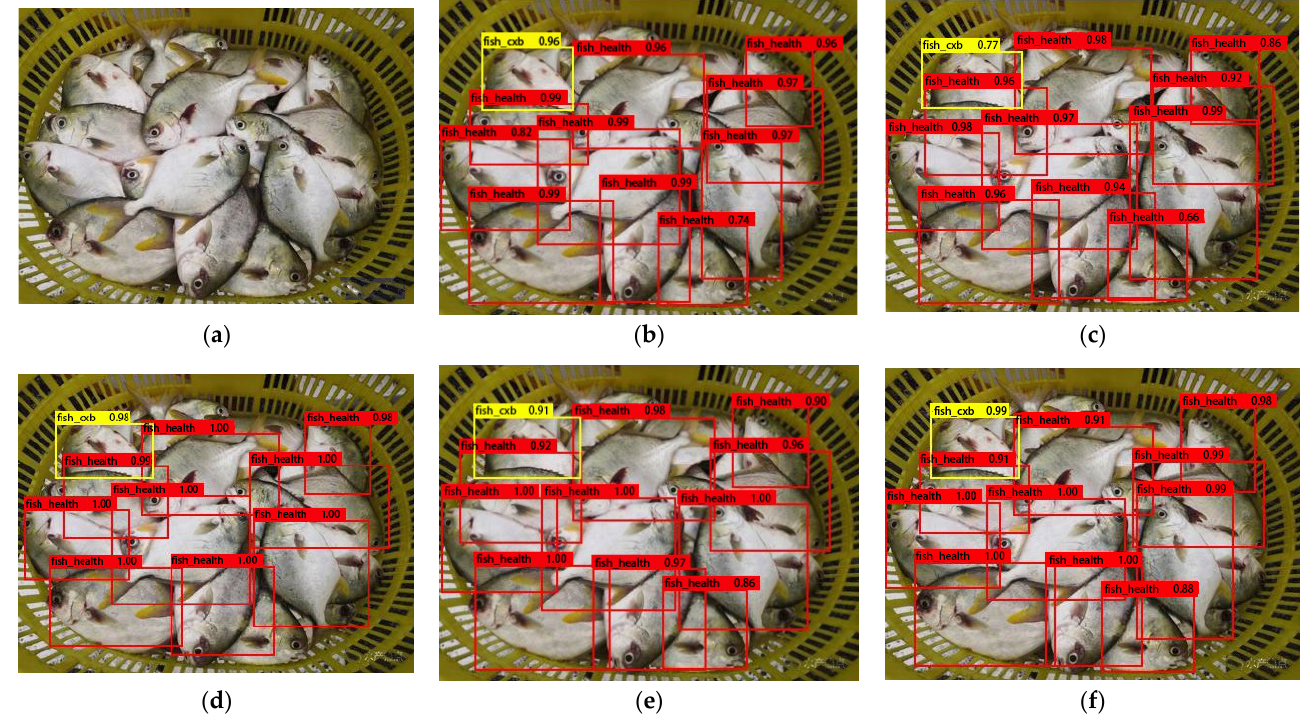
Figure 6. Fish skin disease detection effect on snubnose pompano with Hemorrhagic Septicemia ( a )